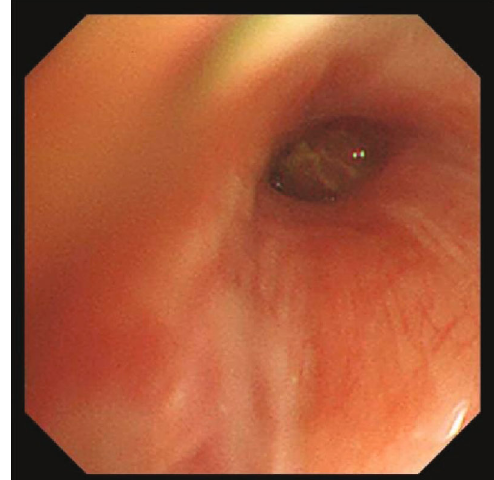
Figure 2: Bronchoscopy showed that the lateral branch of the right middle lobe was blocked.